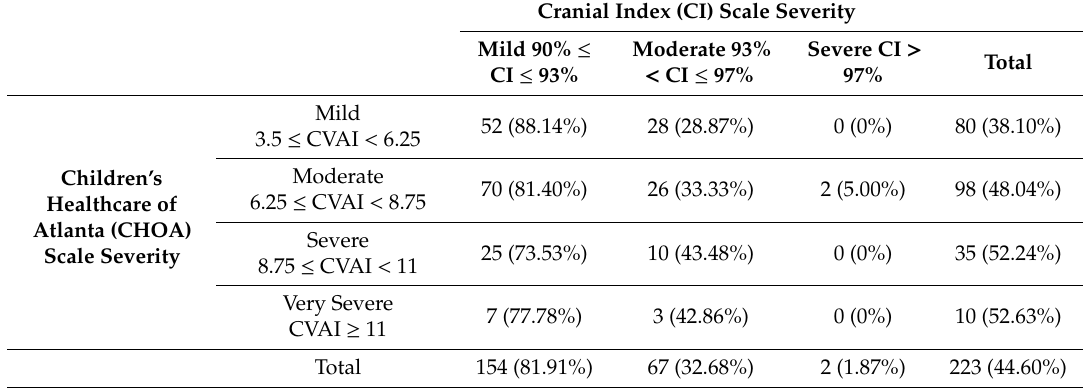
Table 3. Number of subjects who achieved full cranial correction in each starting severity category 1 , based on the initial cranial vault asymmetry index (CVAI) and cephalic index (CI). Full correction was defined as a CVAI ≤ 6.5 and CI ≤